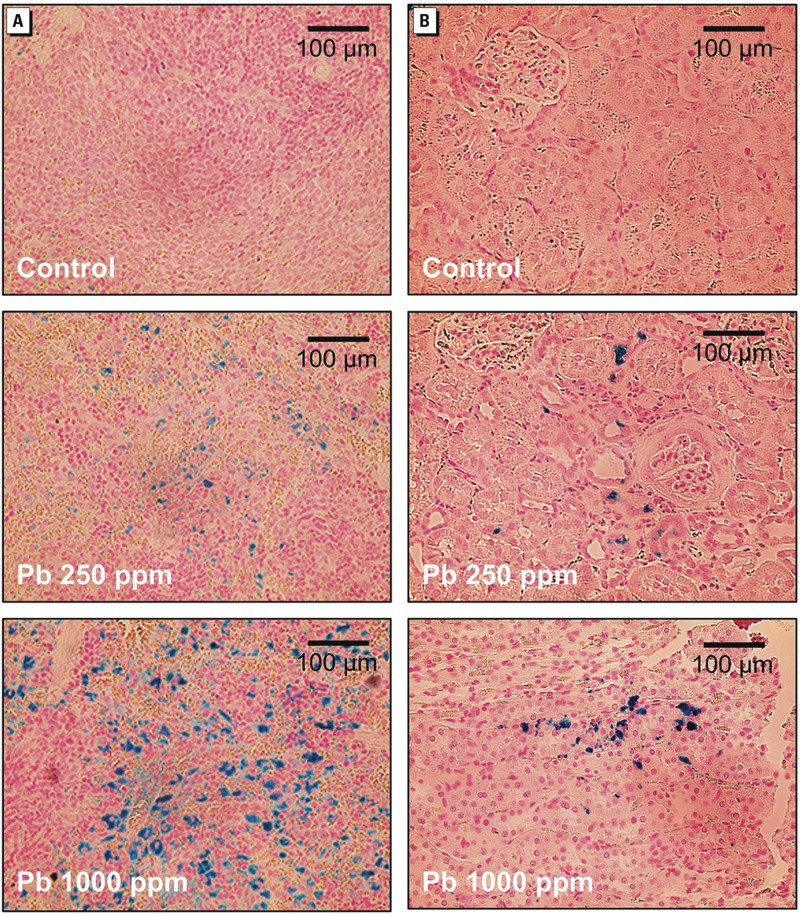
Representative photomicrographs showing the accumulation of iron in the spleen (A) and kidney (B) from rats treated with Pb2+ in drinking water [0 (control), 250, or 1,000 ppm] for 12 weeks. Iron is indicated by Prussian blue staining; bars = 100 μm.